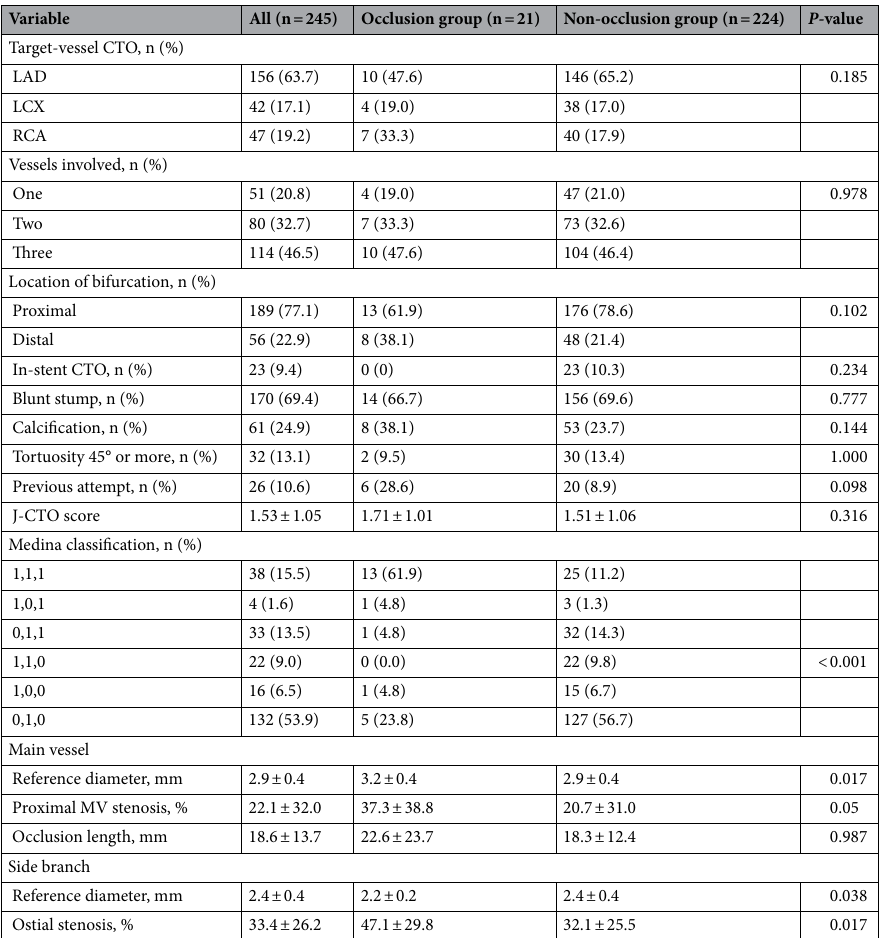
Table 2. Angiographic data. The data are presented as the number (percentage) or mean and standard deviation as appropriate. CTO chronic total occlusion, J-CTO Multicenter CTO registry in Japan, LAD left anterior descending artery, LCX left circumflex artery, RCA right coronary